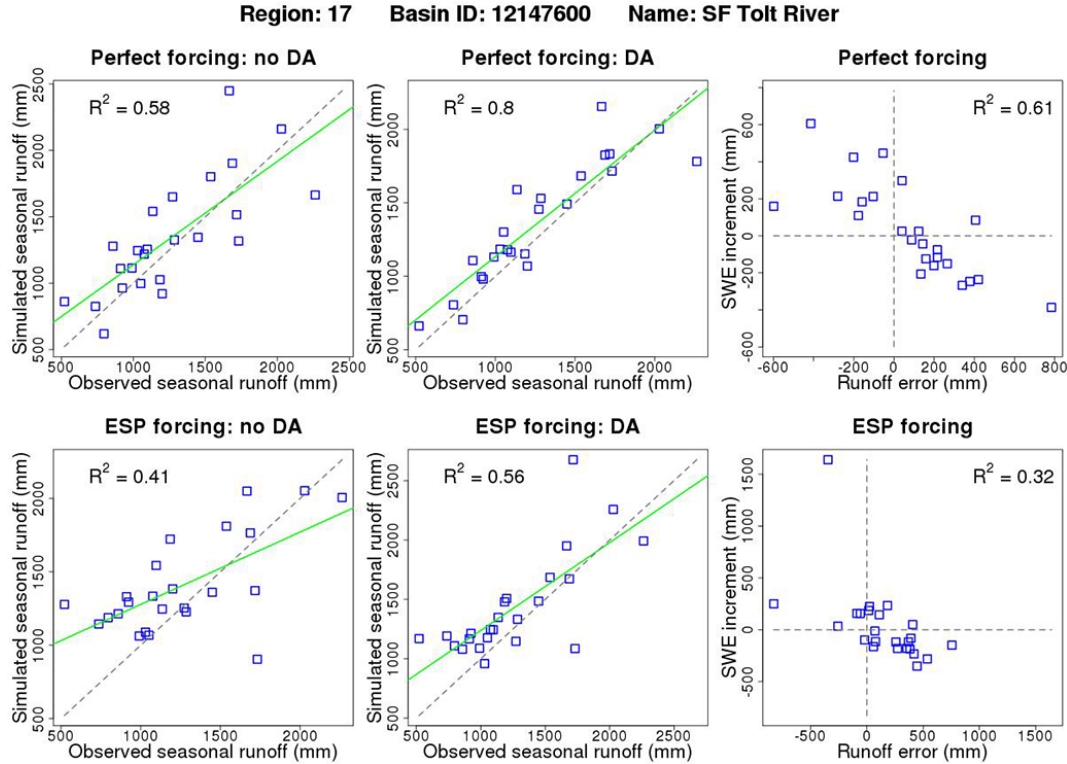
Figure 12. Scatterplots for seasonal runoff and SWE on the DA date for the south fork of the Tolt River. Black dashed diagonal lines indicate the 1 : 1 line, while the green lines indicate linear regression fits to data. Perfect forcing results are shown in the top row, while ESP results are in the bottom